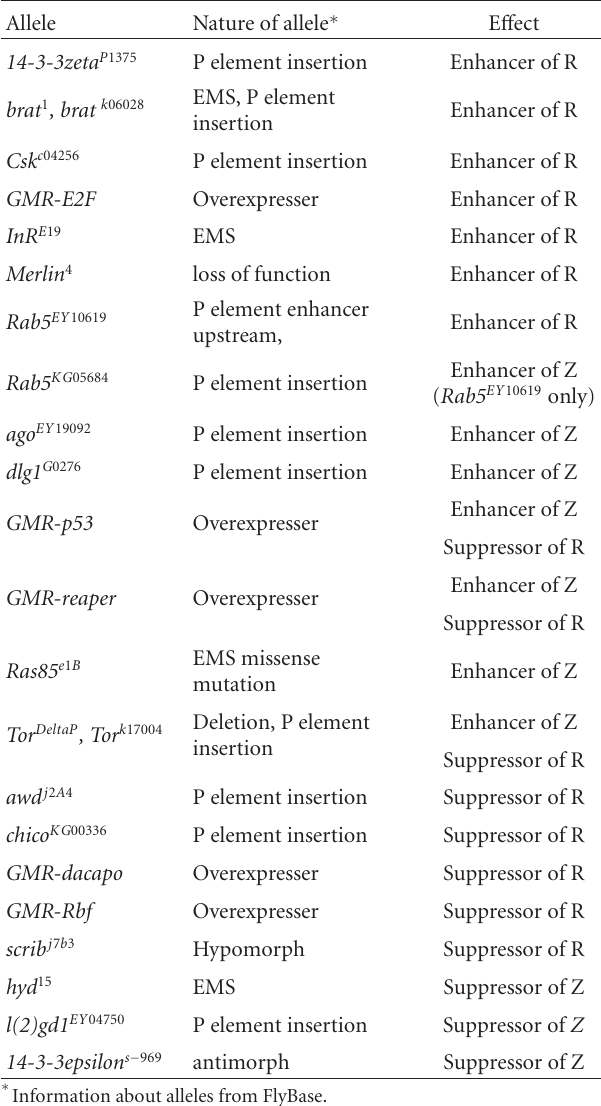
Table 1: Candidate gene screen of tumor suppressors.